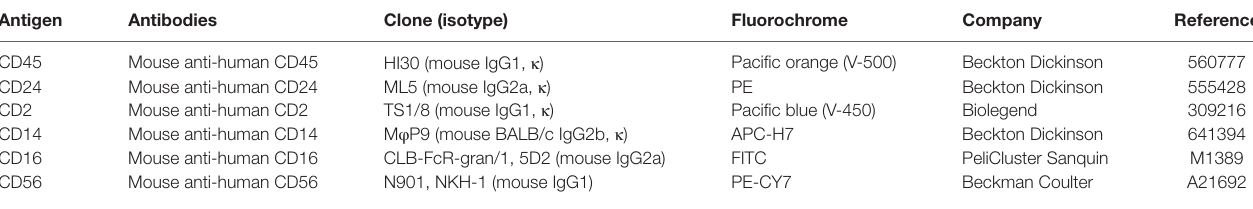
TaBle 2 | List of antibodies used for multiparametric flow cytometry.